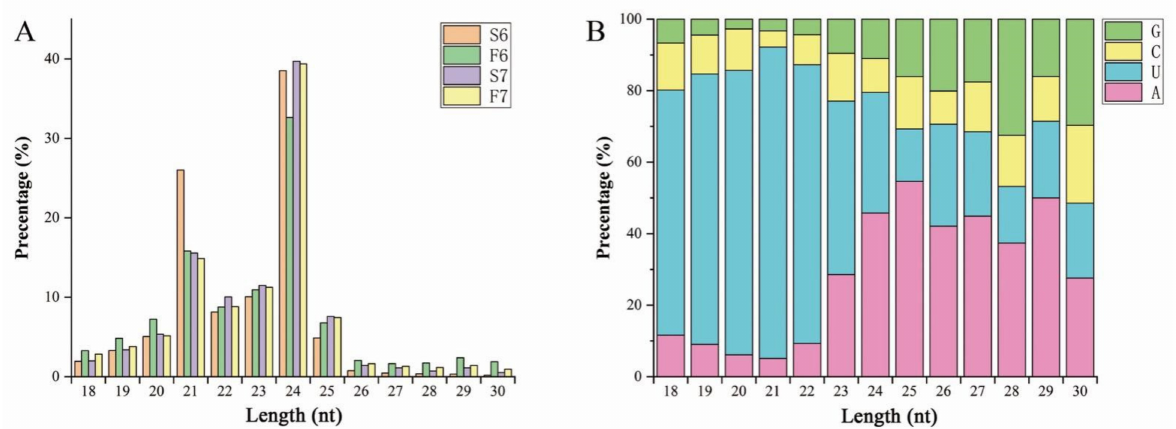
Figure 2. Lengths of small RNAs (sRNAs) and first bases of mature microRNAs (miRNAs) in sequencing libraries. ( A ) Size distribution of sRNA sequences identified in the sequencing libraries. The X-axis represents sRNAs of different lengths, while the Y-axis displays the number of sRNAs of a certain length. ( B ) The first base preference of mature miRNAs in the sequencing libraries. The X-axis represents the length classification of the sRNAs, and the Y-axis displays the proportion of mature miRNAs with a certain base type as the first